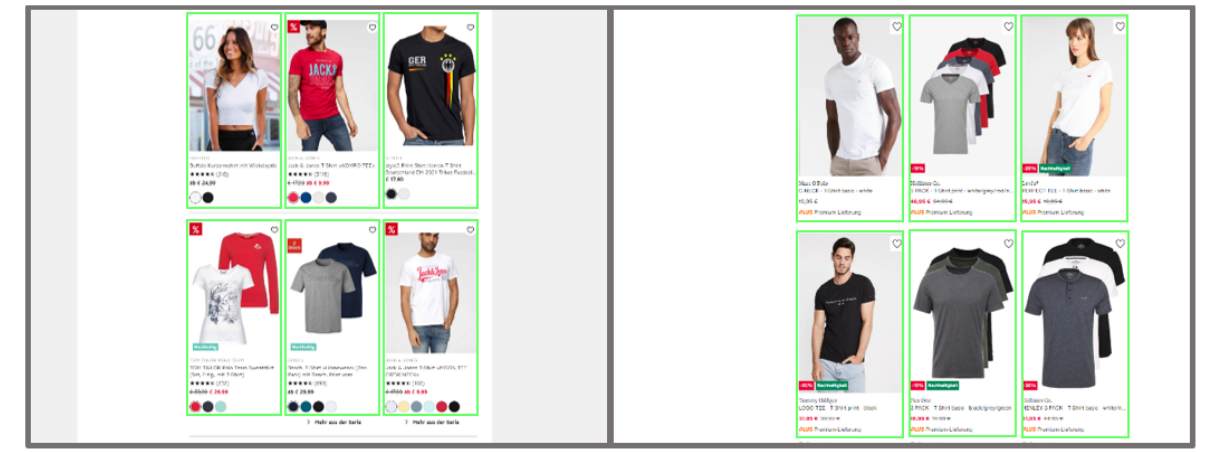
Figure 1. Excerpts from the screenshot of online shop A ( left ) and online shop B ( right ) with areas of interest outlined in green.